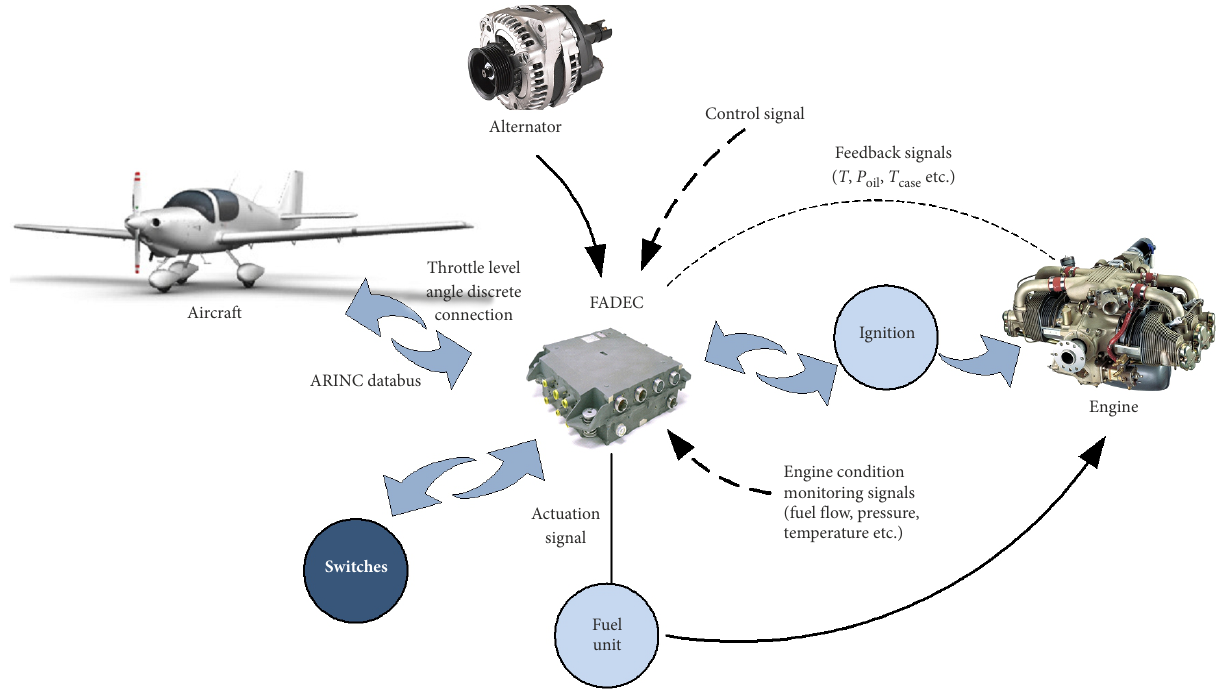
Figure 2. FADEC wiring diagram on the aircraft (study by authors based on Austrian Technik (2017) and Menne (2007))